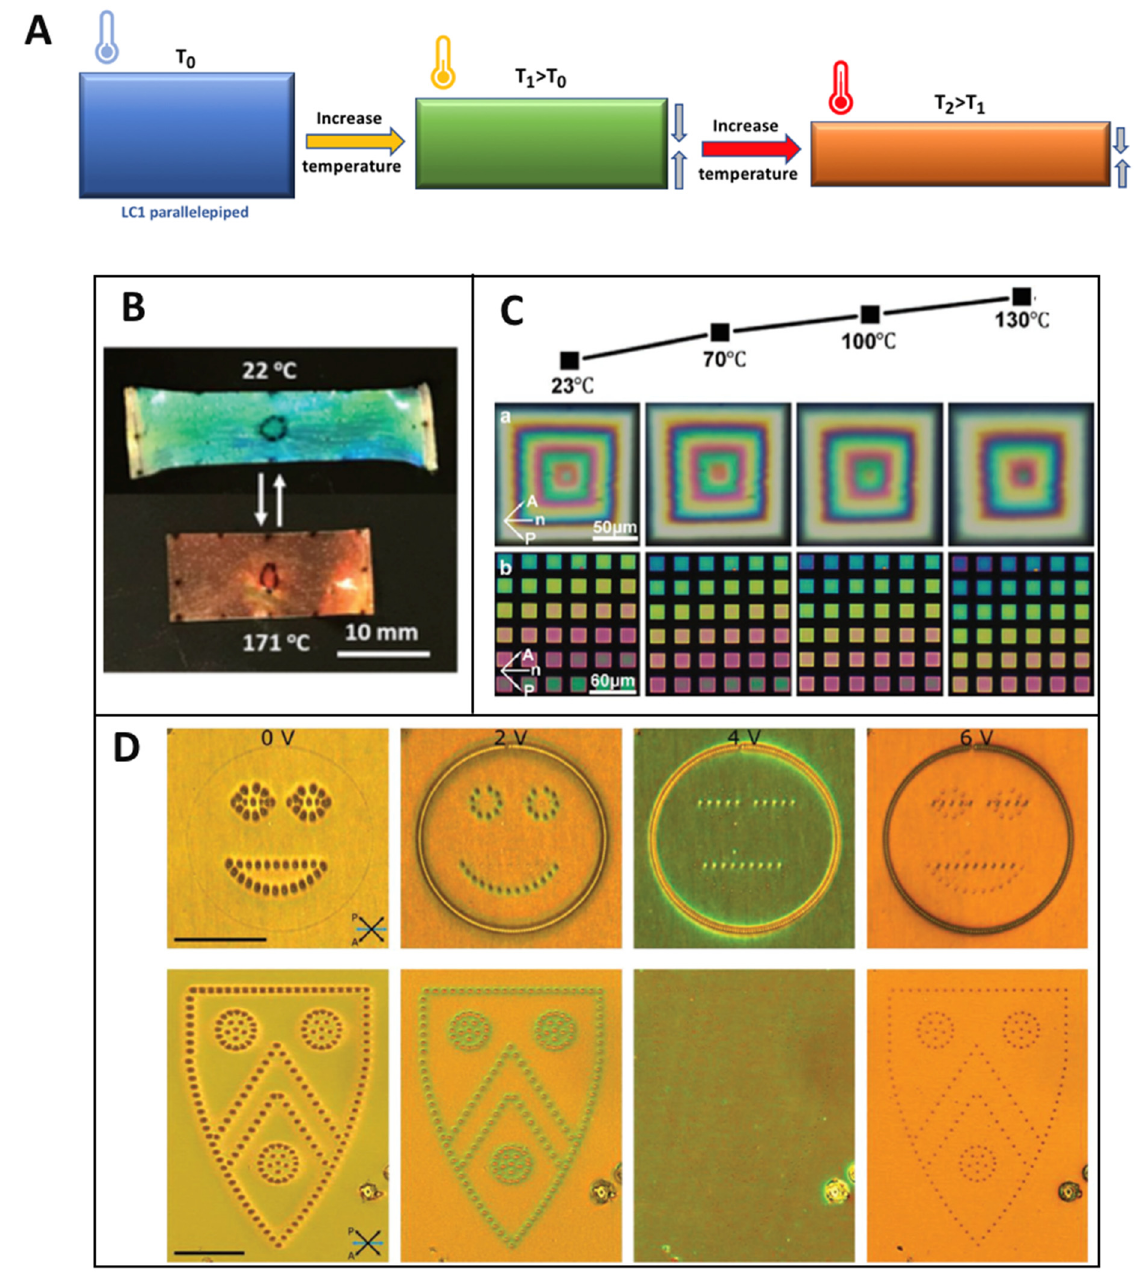
Figure 8. ( A ) Scheme of the change of color by the shrinking effect caused by thermal actuation. ( B ) LC color change principle with thermal actuation for a film example [65]. Reproduced under the squared structures that change color with the increase in temperature for the design of LOGOs [68].